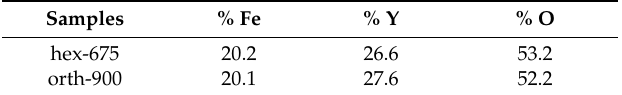
Figure 4. High resolution X ‐ ray photoelectron spectroscopy (XPS) scans of hexagonal and orthorhombic YFeO 3 . ( a ) Y 3d; ( b ) O 1s, and ( c ) Fe 2p region. Table 1. XPS surface atomic ratios for hexagonal and orthorhombic YFeO 3 .